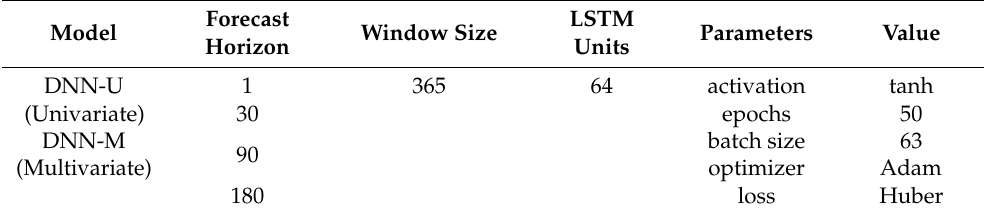
Table 4. Summary of model parameters for the DNN-U and DNN-M